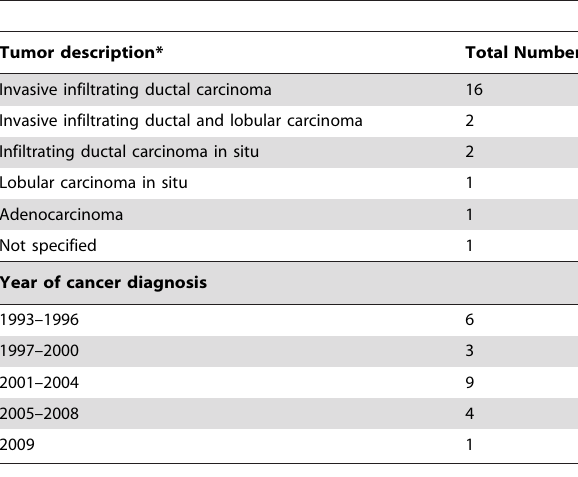
Table 1. Histopathology and years of diagnosis of the 23 breast cancer cases in the WIHS and HERS cohort